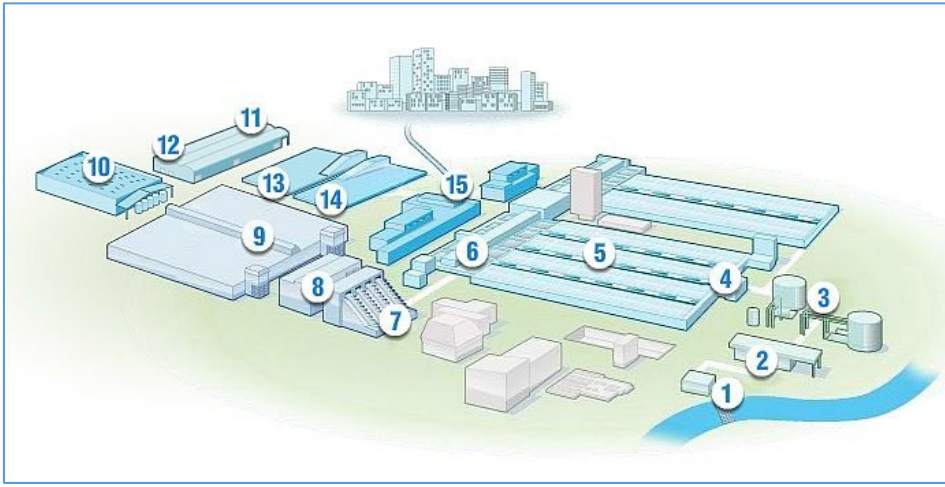
Figure 3. Drinking water treatment plant (DWTP) at Sant Joan Despí schematic.